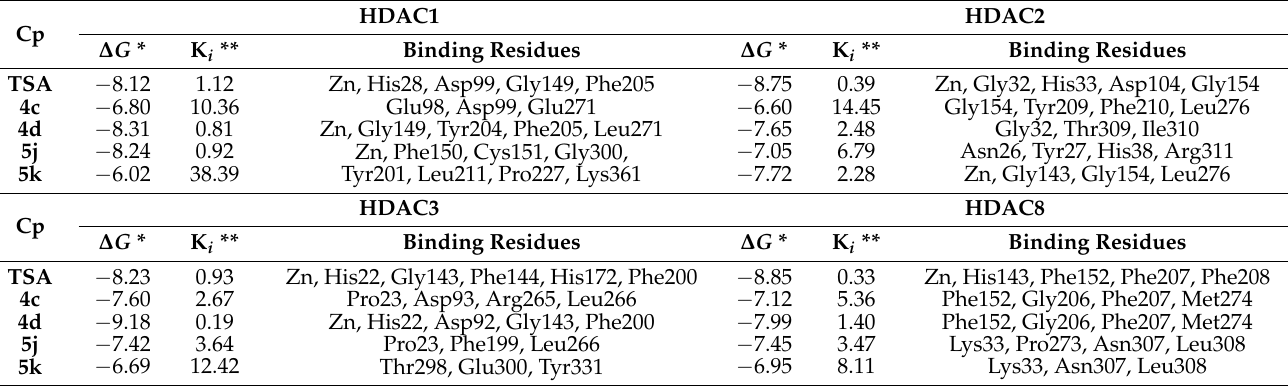
Table 2. In silico histone deacetylase inhibitory activity of the selected